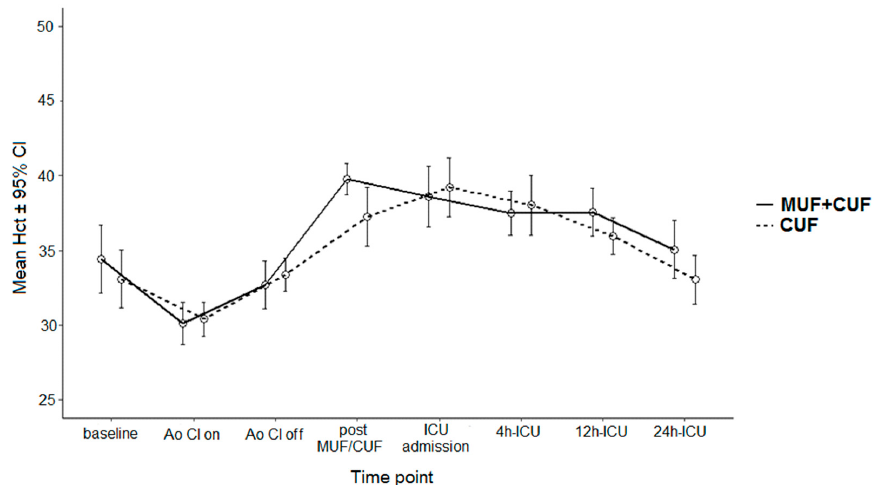
Figure 2. Hematocrit data for lower weight cohort—Ao Cl on—cross clamp on; Ao Cl off—cross clamp off; MUF—modified ultrafiltration; CUF—conventional ultrafiltration, ICU—intensive care